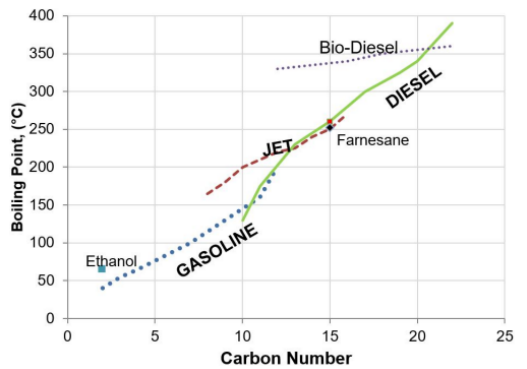
Figure A1. Carbon number comparison for gasoline, jet and diesel fuels